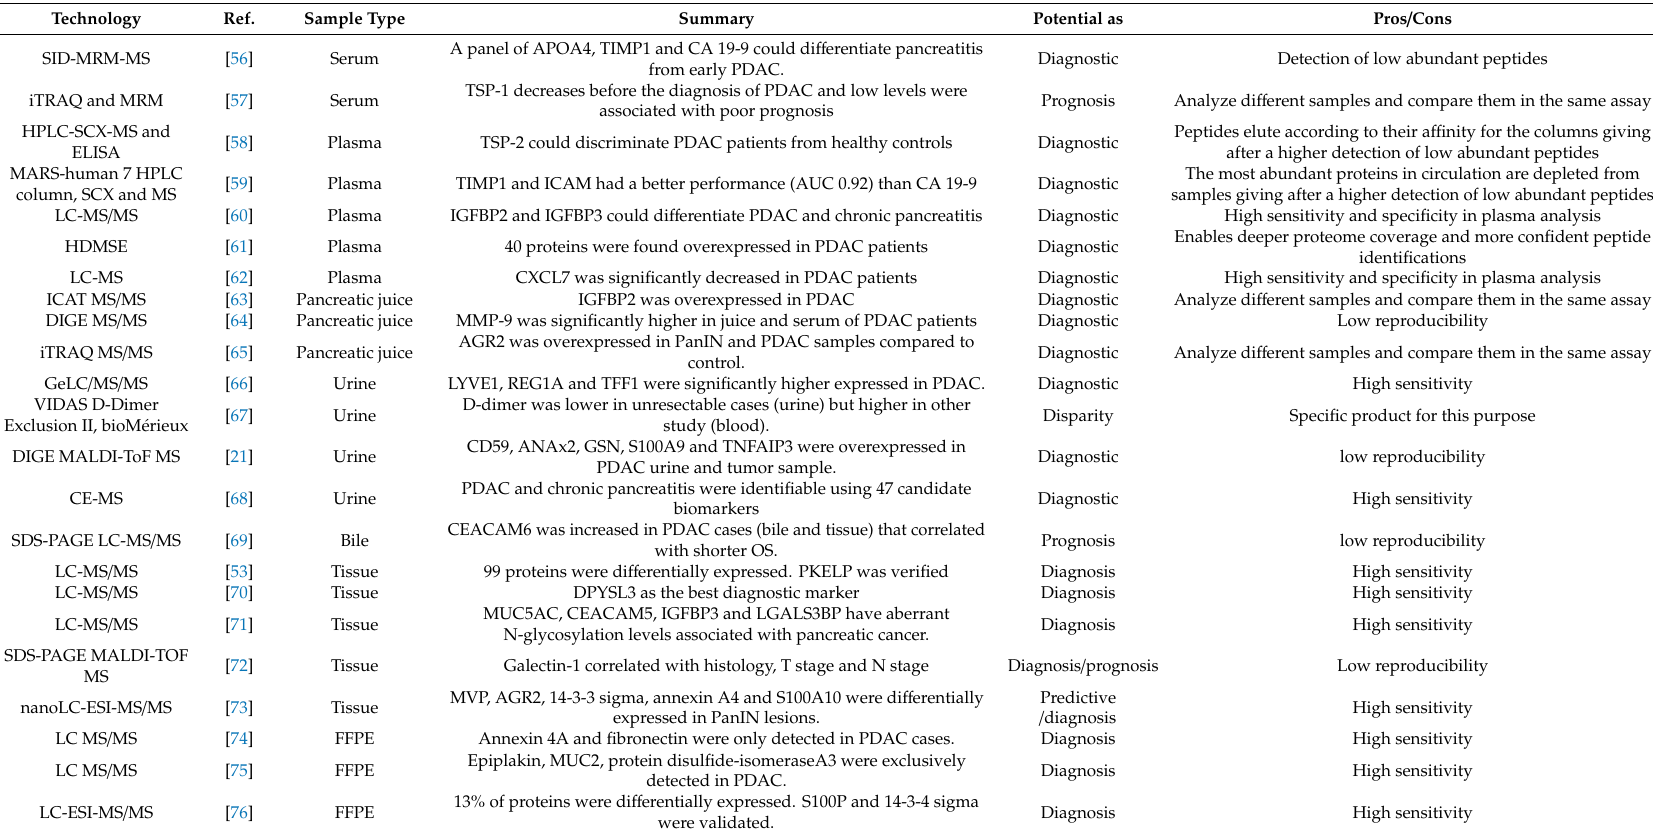
Table 1. Summary of proteomic studies in PDAC listed by the type of sample used in di ff erent proteomic